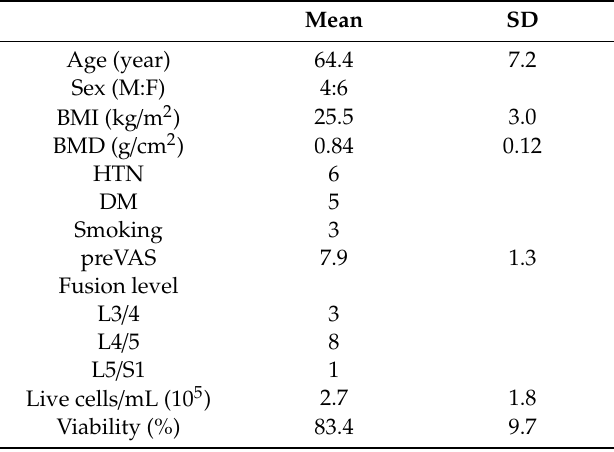
Table 1. Demographic characteristics of